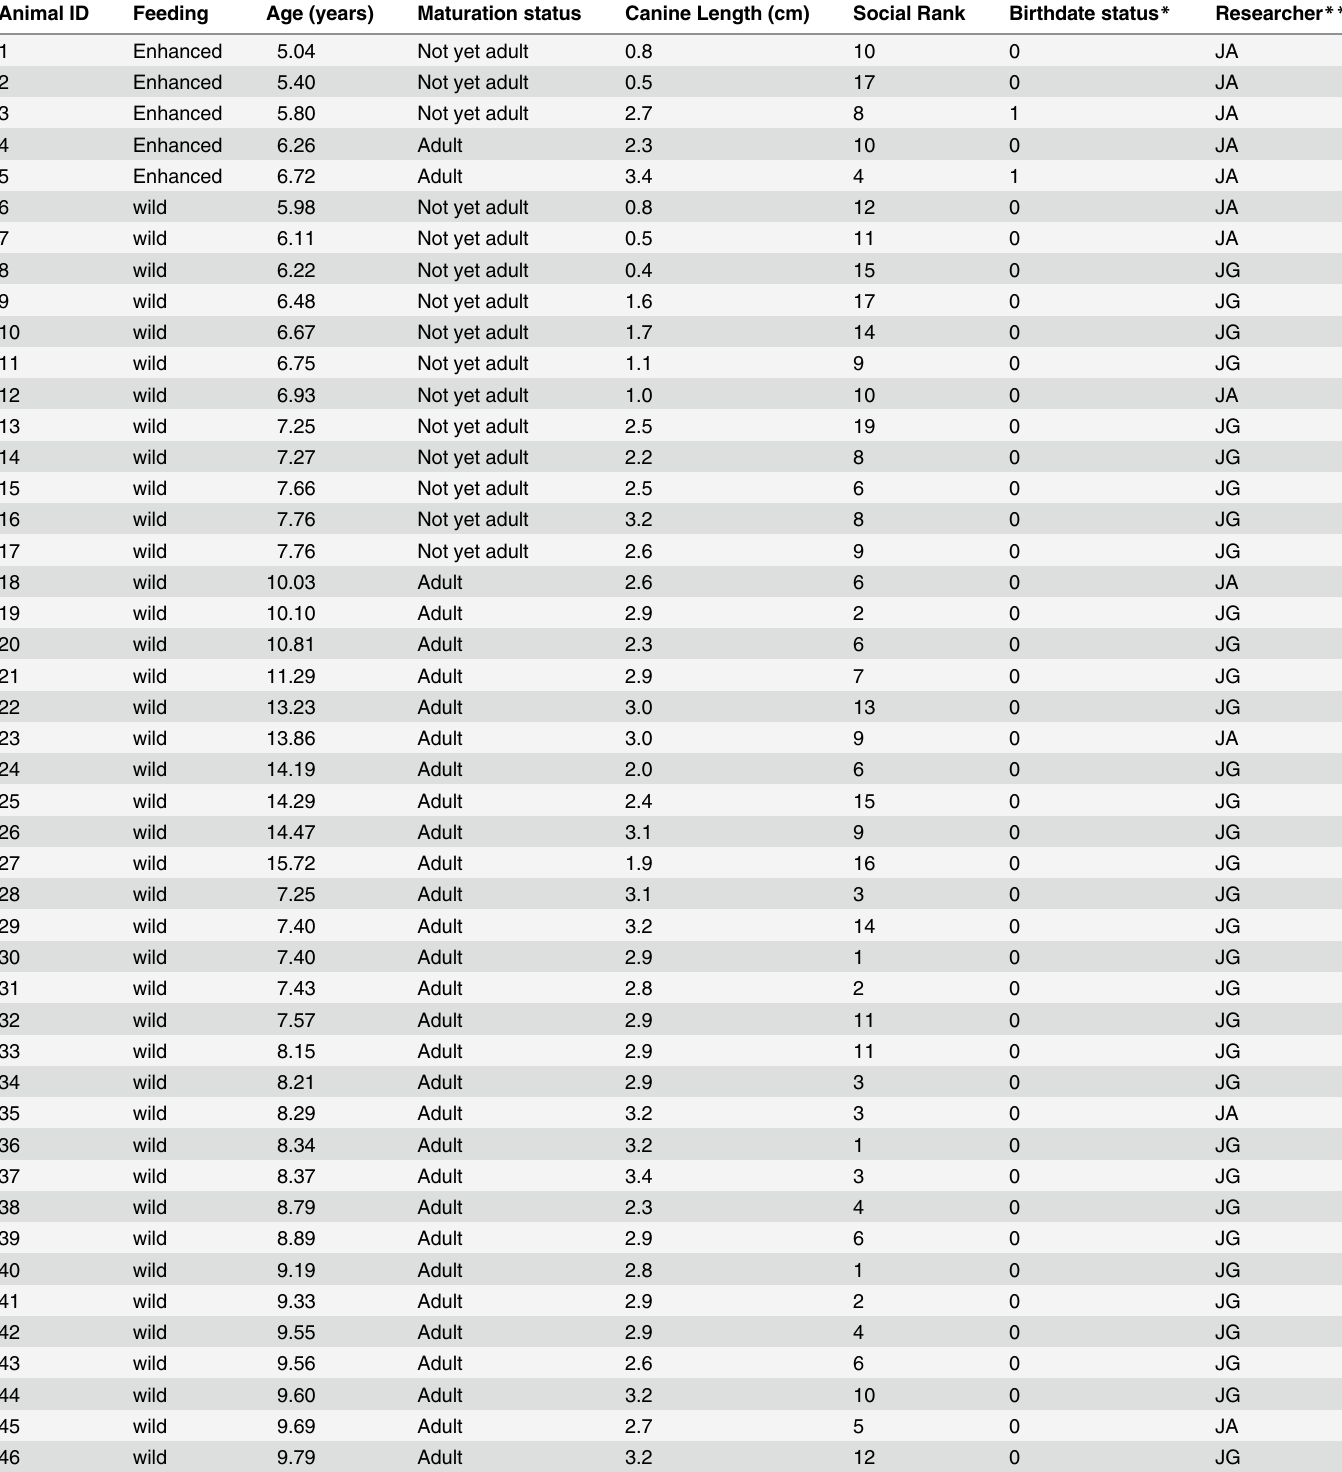
Table 1. Study subjects (N = 5 food-enhanced and 75 wild-feeding male baboons), including feeding condition, age, maturation status, social rank, and canine length. Animal